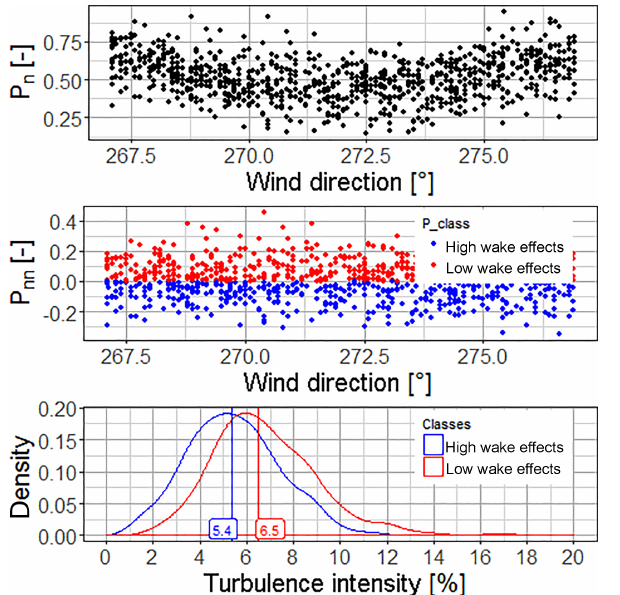
Figure 5. (a) Power of AV5 normalised with the power of AV4 for a 10 ◦ sector around the full wake for wind speed range 8 ± 1ms − 1 . (b) Wind direction dependence-corrected normalised power. Each 2 ◦ bin is normalised with its bin average. Data are classified into high and low wake effects. (c) Density distribution of the turbulence intensity from the met mast for each data subset with